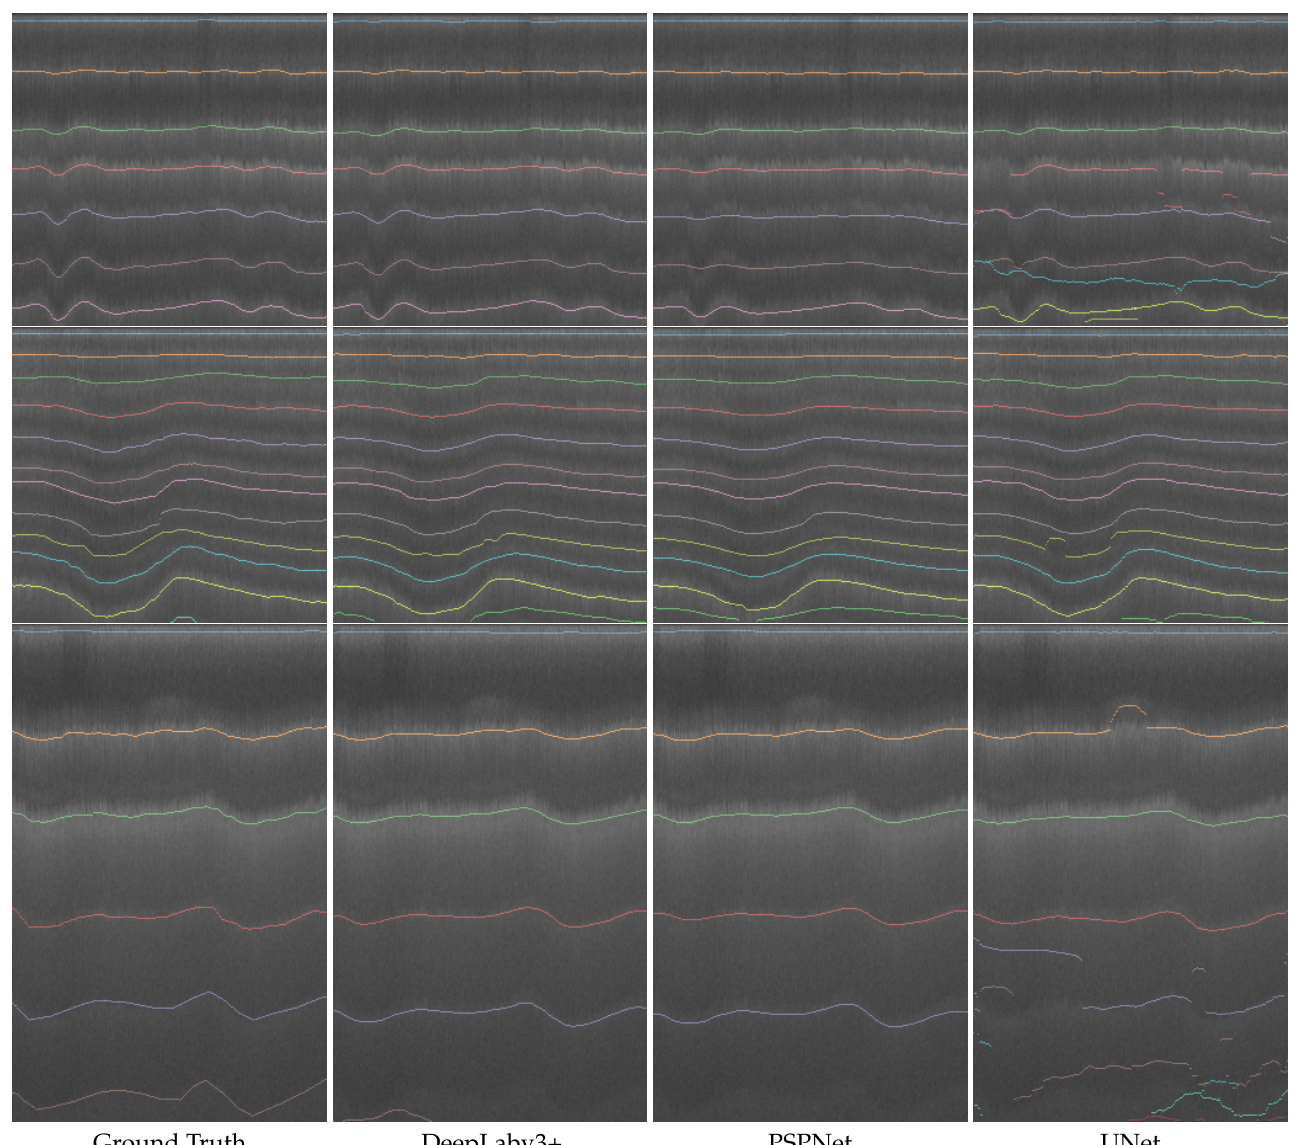
Ground Truth DeepLabv3+ PSPNet UNet Figure 11. Radar images overlaid with Ground Truth layers ( first column ) and layers predicted from the three FCNs: DeepLabv3+ ( second column ), PSPNet ( third column ), and UNet ( fourth column ). The results shown are from each network’s best output in terms of mean IoU (Table 3). More examples are in Figure 12. Table 2. Network accuracy on the train and test sets. Numbers in bold represent the best